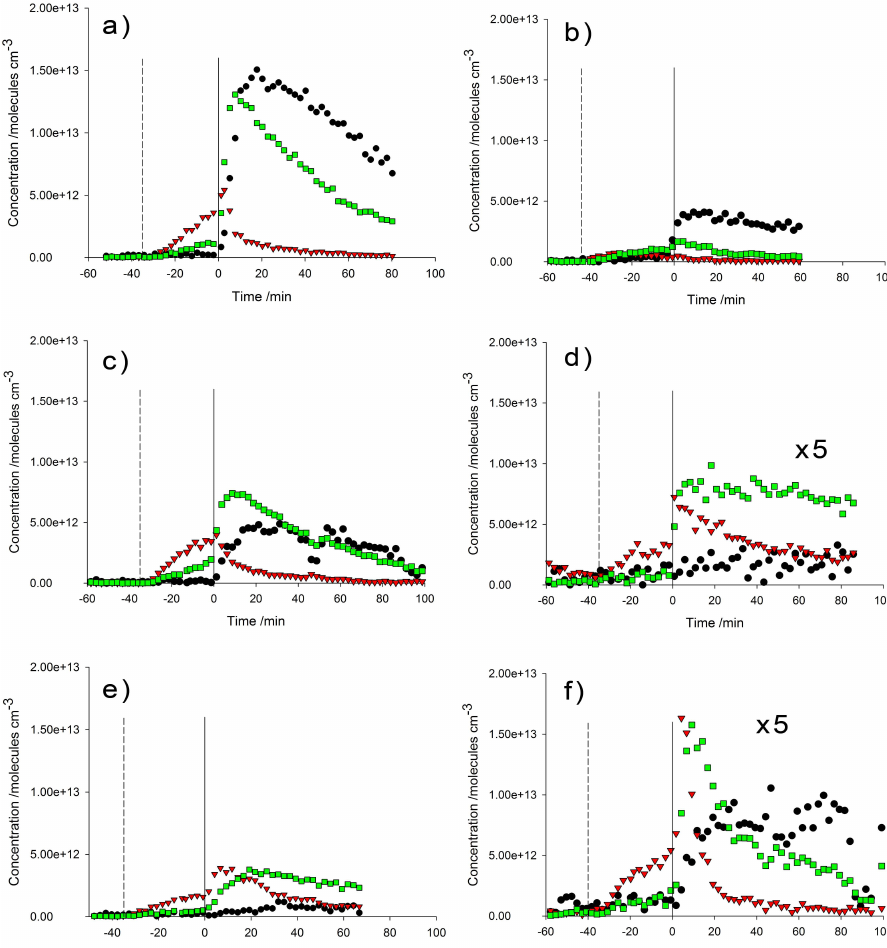
Fig. 3. Time evolution of the dihalogen concentrations during a typical experiment: Br 2 (red triangles), Cl 2 (black circles) and BrCl (green squares). Each point represents the average of a 2.5min time bin (77 data points). The dashed line indicates the time at which the ozone generator was turned on and the solid line ( t =0) indicates the time at which the samples were illuminated. (a) BASE scenario conditions as in Table 1; BASE scenario conditions except with (b) high purity NaCl(s) (Br − <0.001 wt%) to prepare solution; (c) 360nm long-pass filter; (d) coarse mode snow, scaled up by a factor of 5; (e) pre-freezing pH=4.3; (f) snowpack T=252 ± 1K, scaled up by a factor of